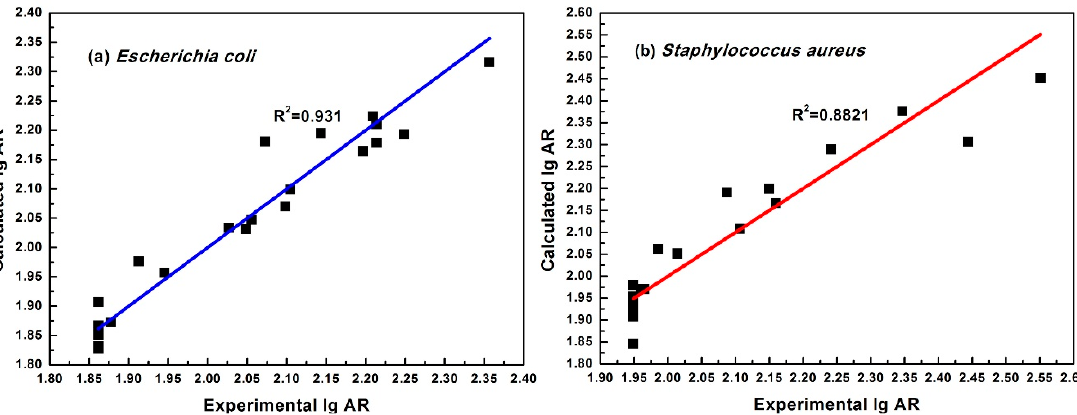
Figure 3. Experimental versus calculated values according to the optimal models. ( a ) is for best model against E. coli , ( b ) is the for model against S. aureus .